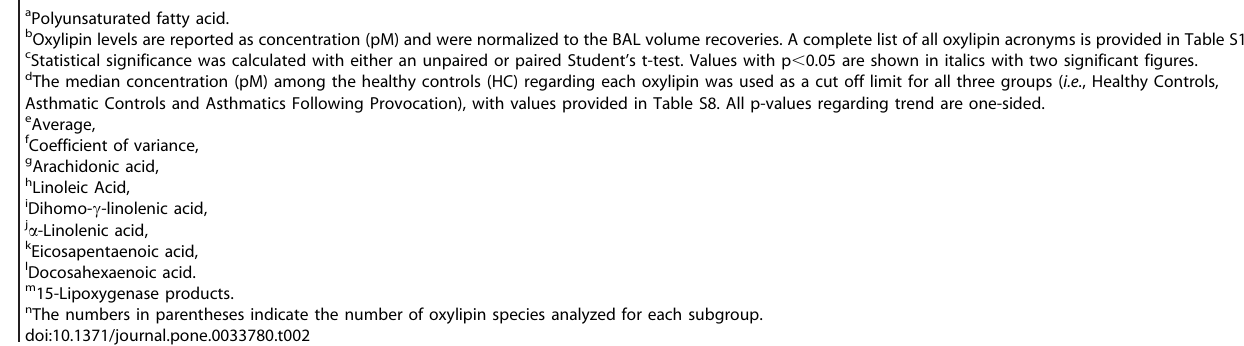
PUFA a Oxylipin b (pM)